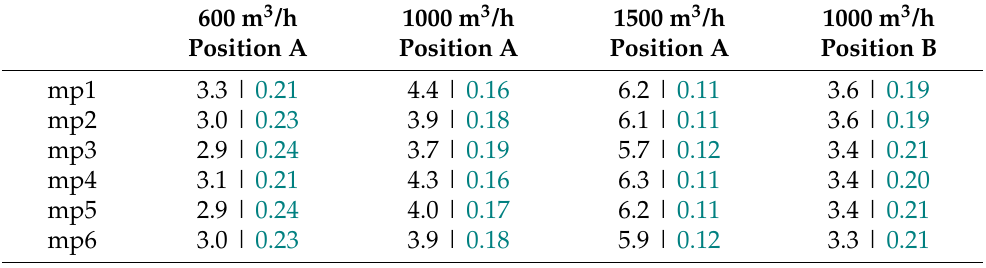
Table 2. Test aerosol particle concentration decay rates and half-lives for config. I empty for different flow